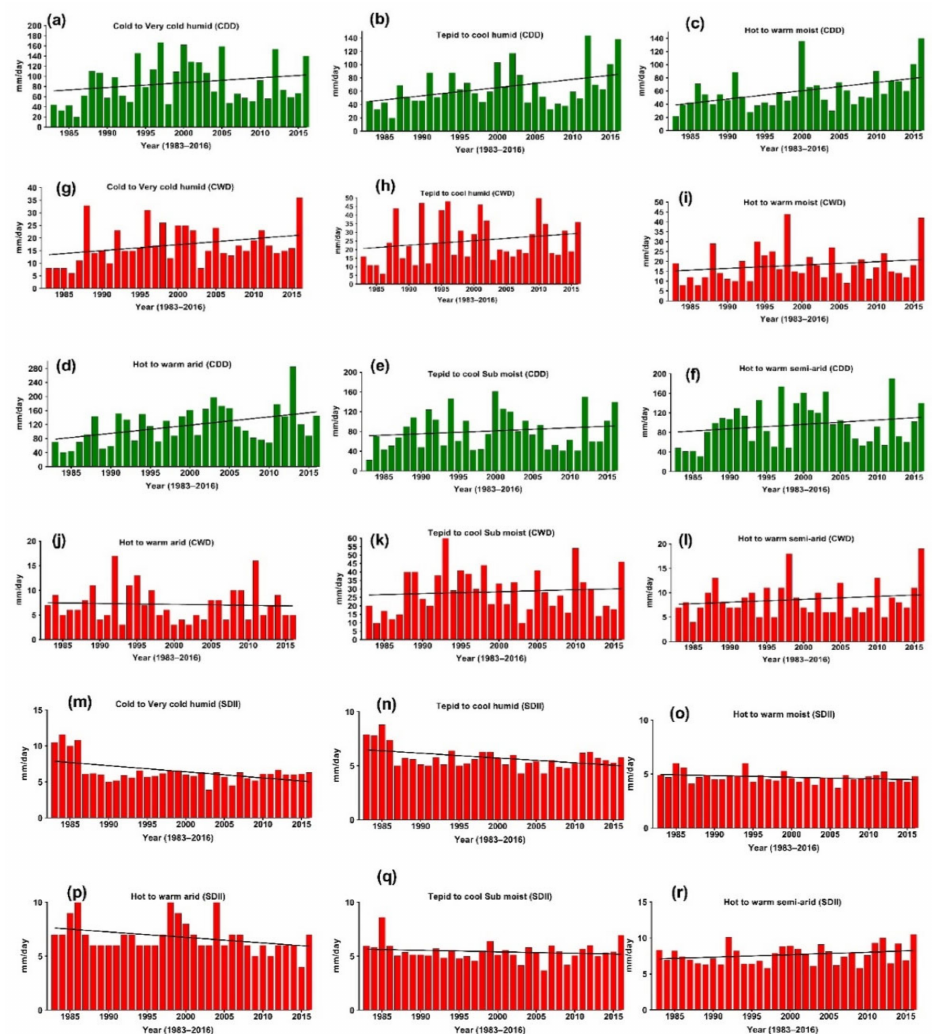
Figure 9. Consecutive dry days (CDD) ( a – f ), Consecutive wet days (CWD) ( g – l ), and simple daily intensity index (SDII) ( m – r ) over agroecological zones for the period